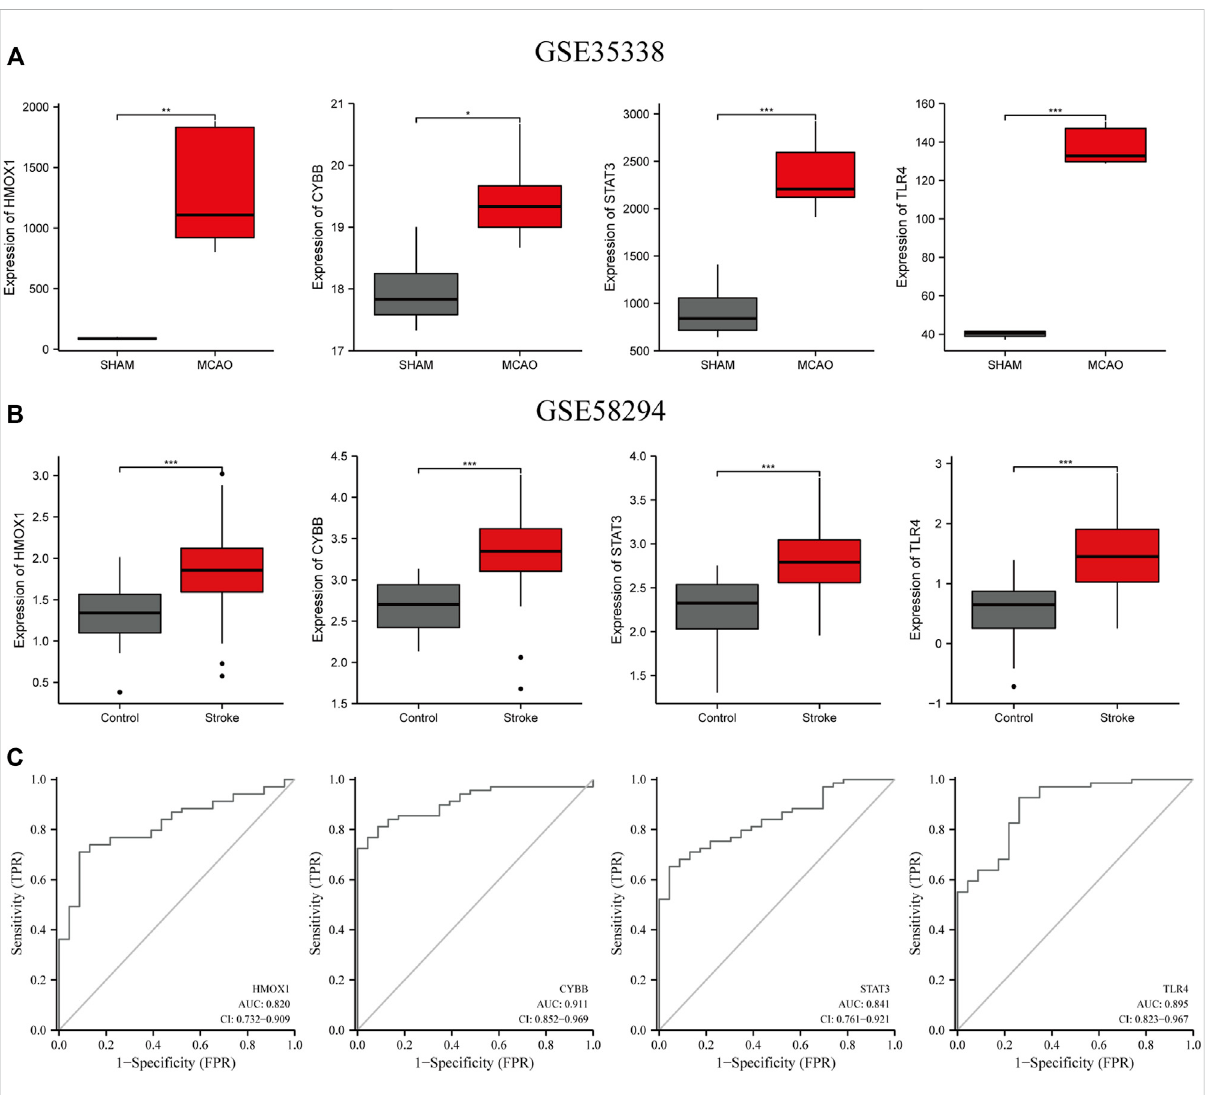
FIGURE 6 Veri fi cation of theexpression levels of the four candidate genes (HMOX1, CYBB, STAT3, TLR4) (A) in MCAO and sham mice brain samples in the GSE35338 dataset (B) and in the peripheral blood of control and IS patients in GSE58294. (C) The AUC of ferroptosis-related biomarkers in the diagnosis of IS in ROC monofactor analysis in the GSE58294 dataset. ***p < 0.001, **p < 0.01, *p < 0.05. ***p < 0.001, **p < 0.01, *p <